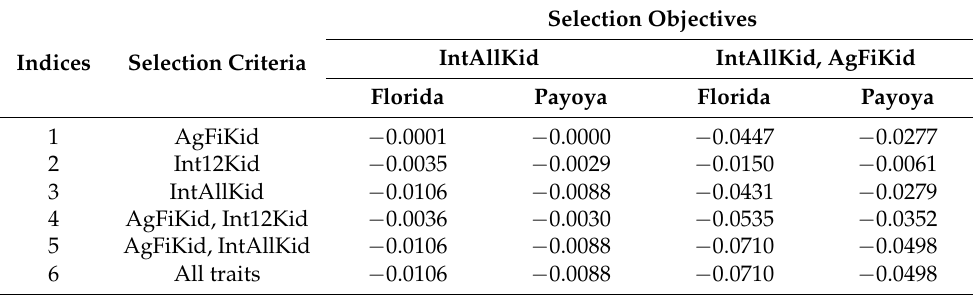
Table 5. Expected genetic responses for the fertility indices in Florida and Payoya breeds 1 .